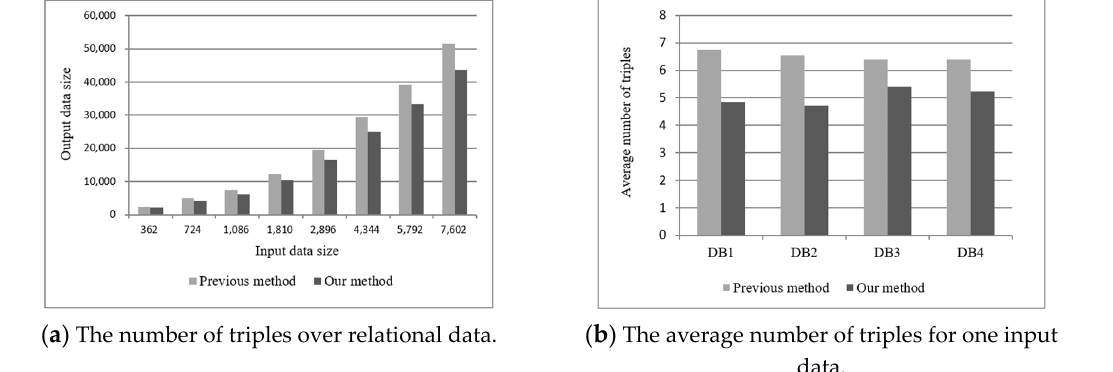
Figure 18. Comparative results of the mapping methods.